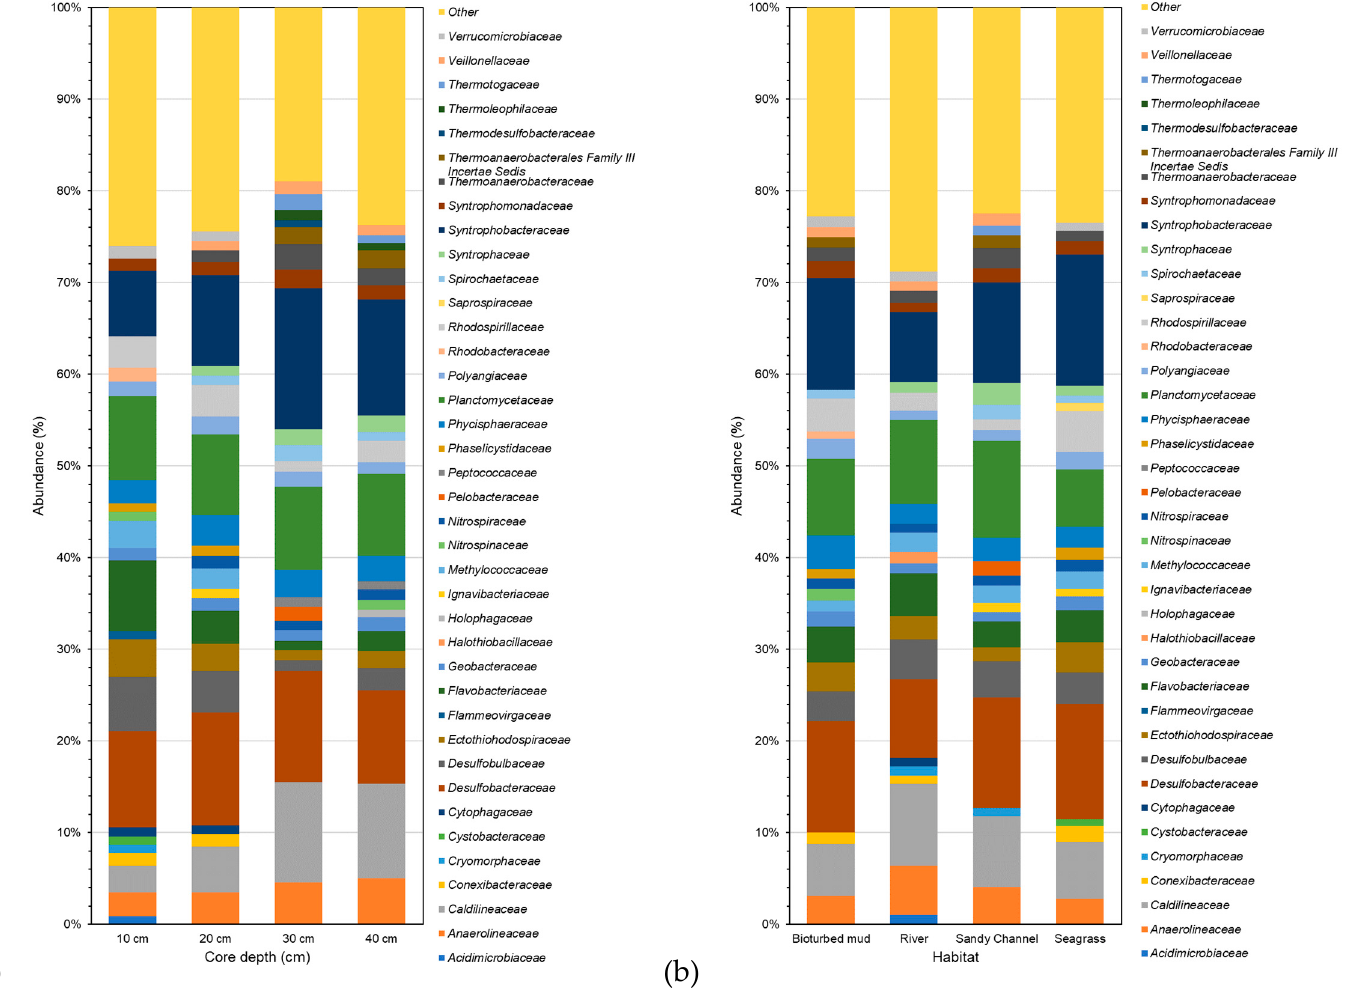
Figure 5. Bacterial classification among ( a ) core depth sampled sites by taxonomy for the cohort family and ( b ) habitat sampled sites by taxonomy for the cohort family.